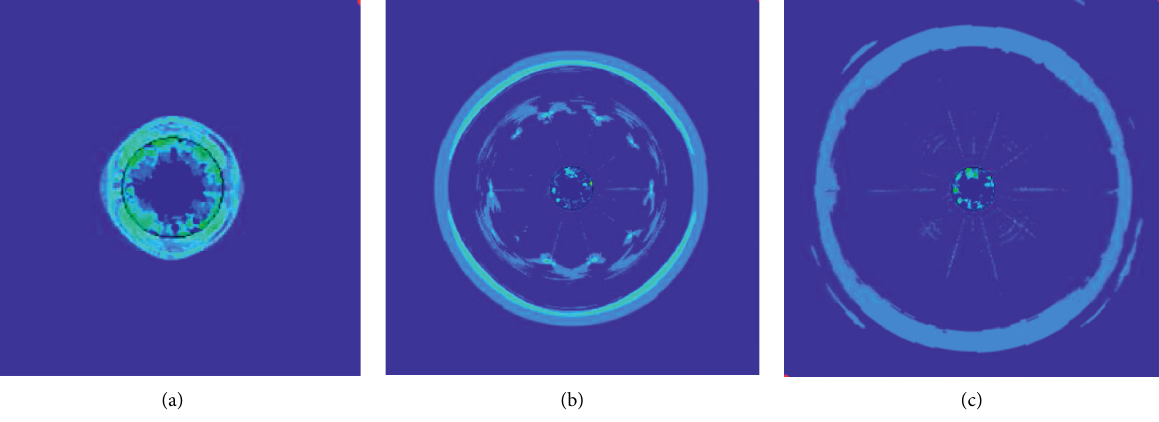
Figure 10: Stress wave spreading process under single-hole